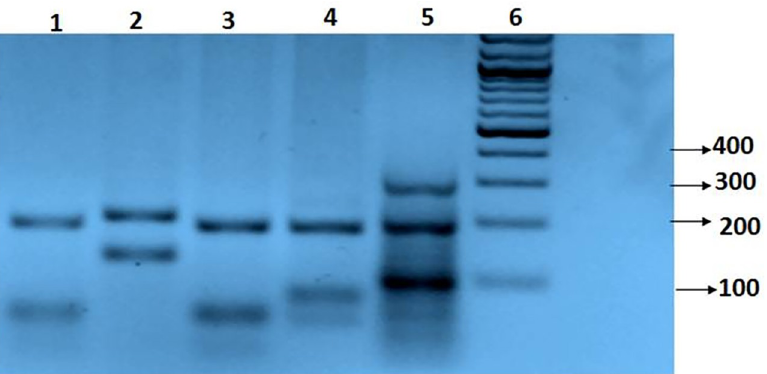
Fig 4. Digestion profile of the ribosomal RNA internal transcribed spacer 1 (ITS1) gene of leishmanial parasites amplified from parasites within sand flies from Palestinian districts, using the restriction enzyme HaeIII : Lane 1, a Ph . sergenti (45A: a representative) sand fly PCR positive for Leishmania tropica collected in Jenin District; lane 2, reference strain of L . major MHOM/SU/1973/5ASKH; lane 3, reference strain of L . tropica MHOM/1998/LRC-747; lane 4, reference strain of L . infantum MHOM/TN/1980/IPT1; lanes 5: AQU lab internal marker for 100, 200 and 290bp & 6, 100 bp DNA ladder.